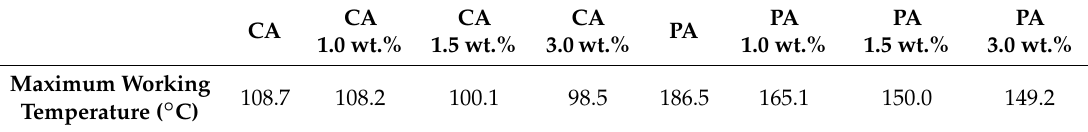
Figure 5. Thermogravimetric analyses (TGA) results of the NEPCM studied: ( a ) Capric acid samples; ( b ) Palmitic acid samples. Table 2. Maximum working temperature of samples under study.